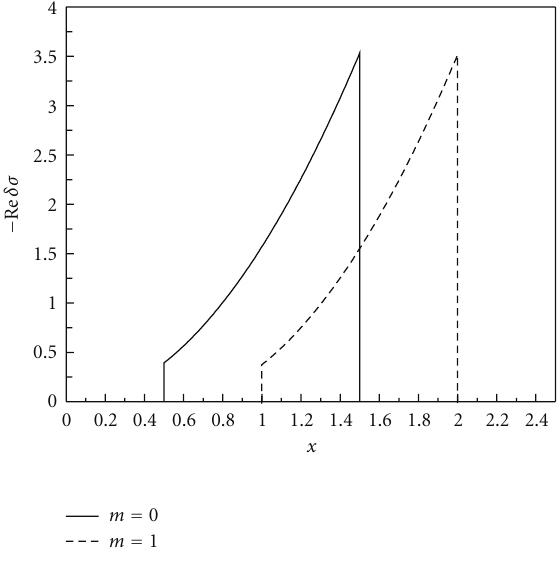
Figure 1: Dependence of Re δσ on x = ω/qυ 0 under η = 0 . 01, q = k